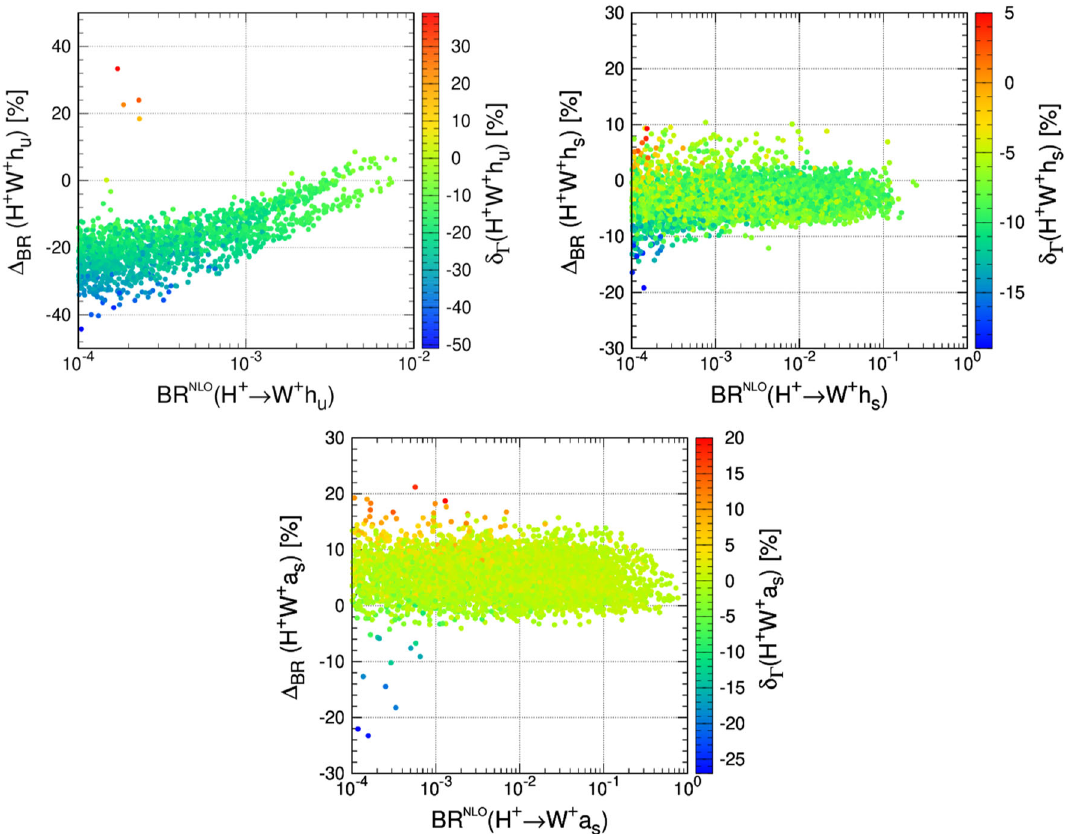
Fig. 3 Relative change in the branching ratio as defined in Eq. (135) for the H + decays into W + h u , W + h s , and W + a s (going clockwise from upper left to lower middle) as a function of the respective SUSY-